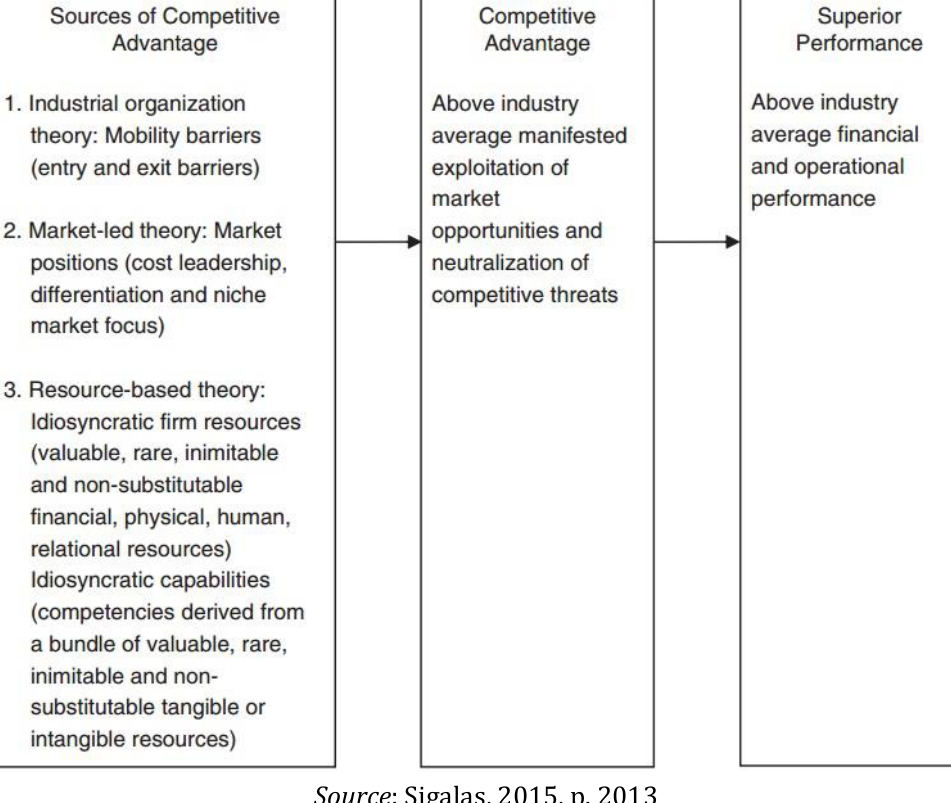
Source : Sigalas, 2015, p.